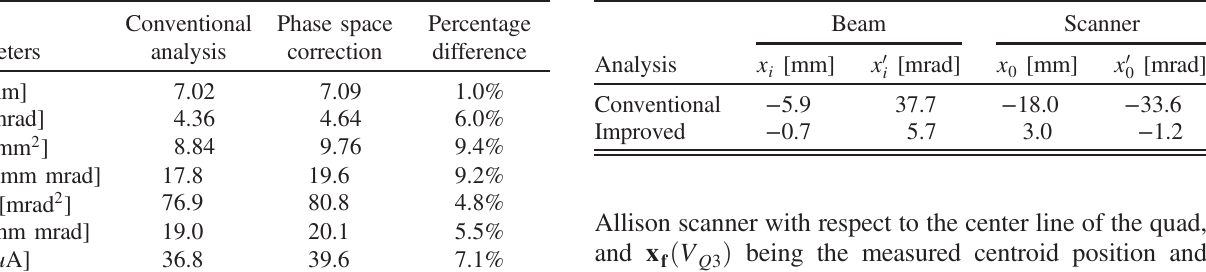
calculated using conven- f